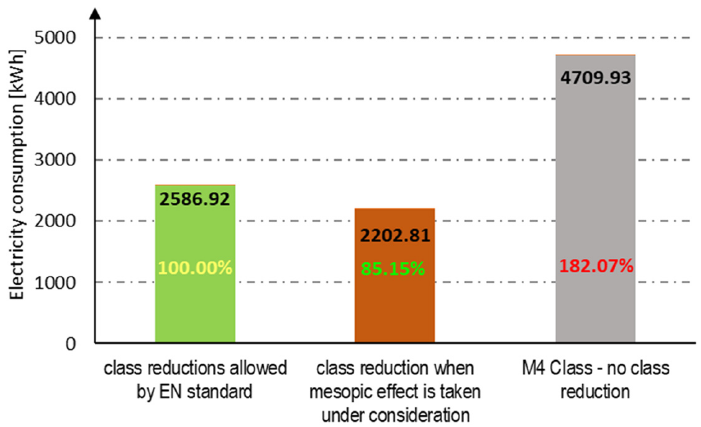
Figure 16. Comparison of electricity consumption for lighting installation without control. with classic control (reduction values for photopic vision), and with control where the photopic reduction values for LEDs are compared against mesopic values.